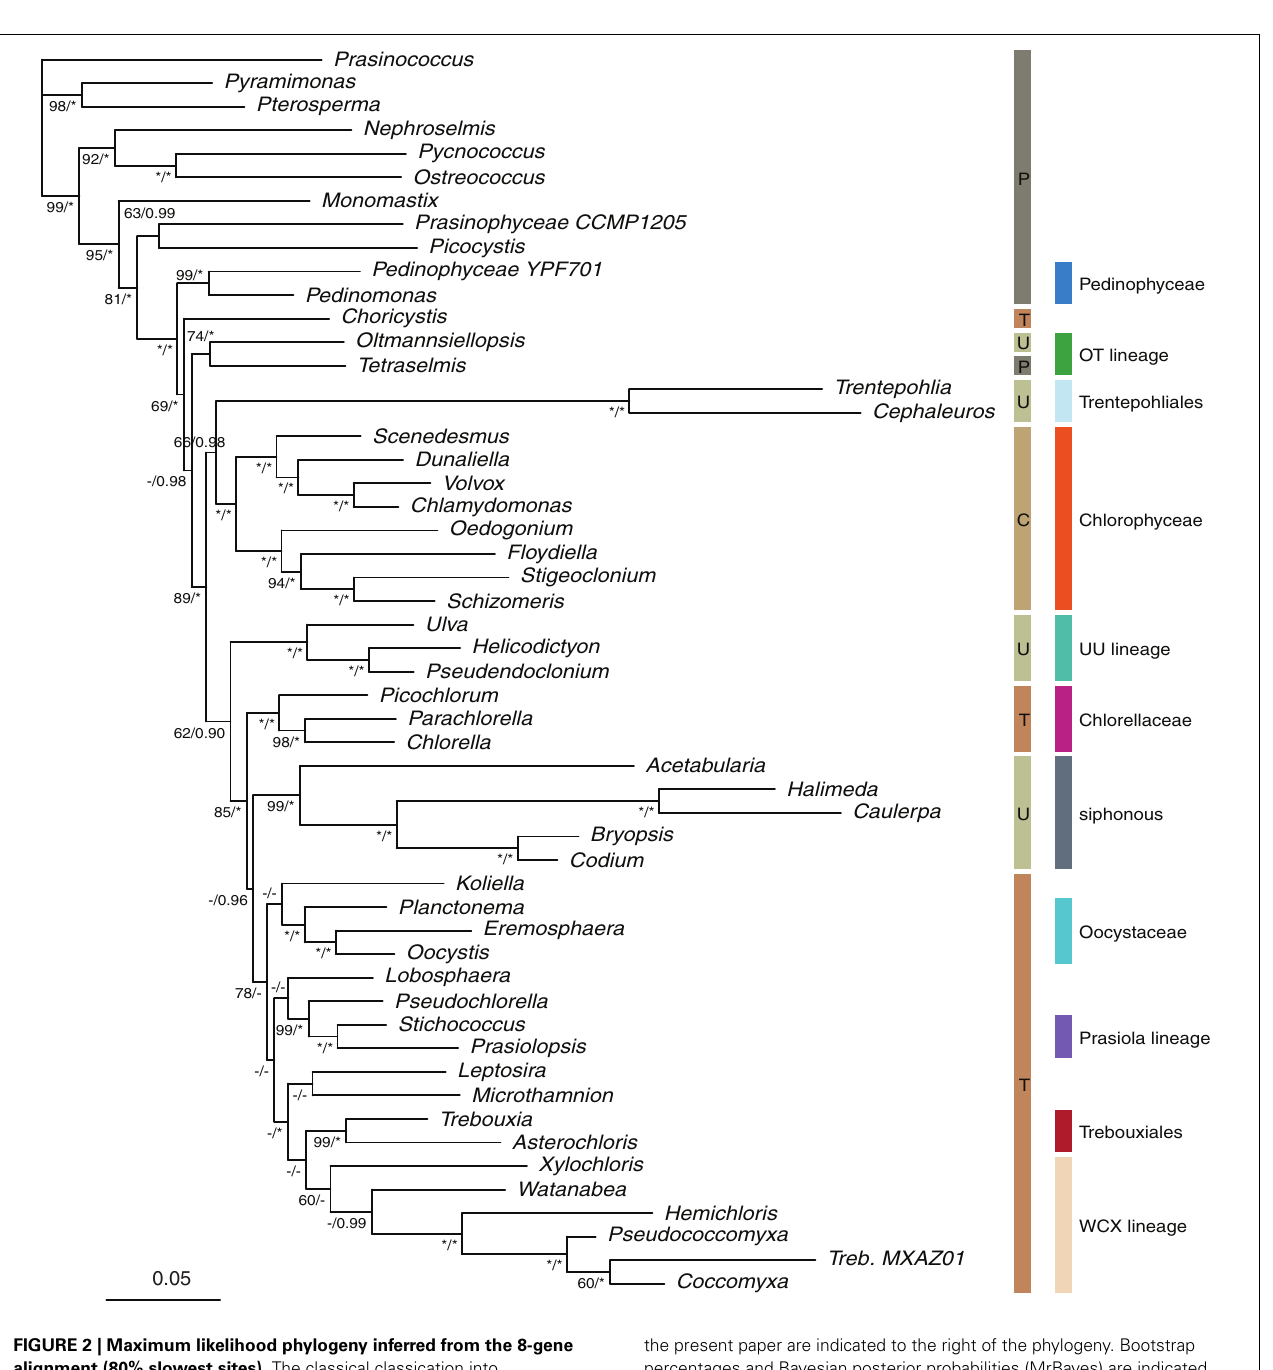
the present paper are indicated to the right of the phylogeny. Bootstrap percentages and Bayesian posterior probabilities (MrBayes) are indicated along branches. Values under 60 BS and 0.90BPP are indicated as -, values of 100BS and 1.00BPP as ∗